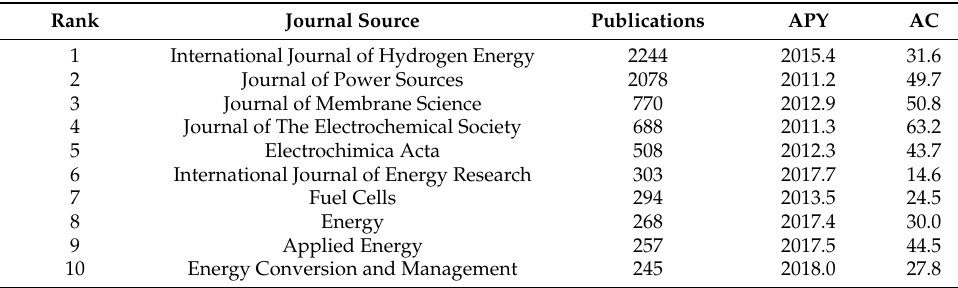
Table 2. Information of top 10 Journals in the PEMFC